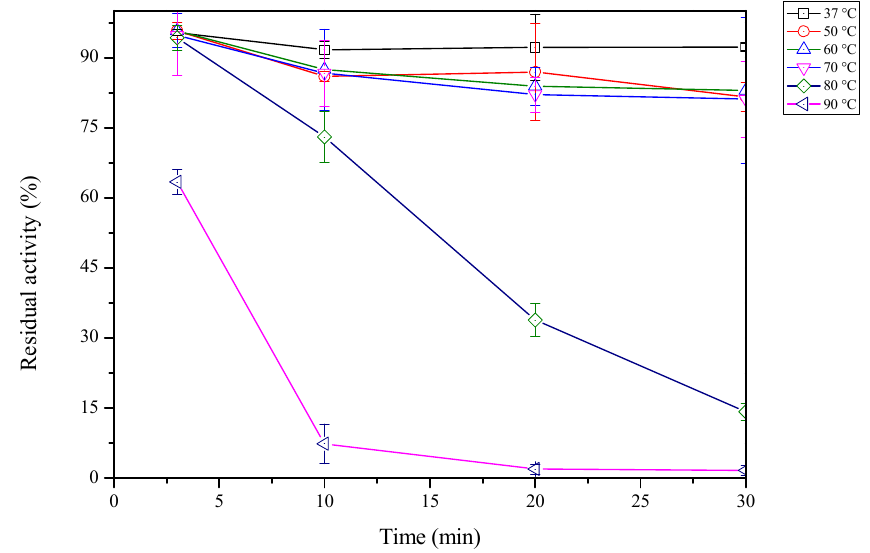
Figure 7. Thermal stability tests for sdCALA, where the initial activity was set as the control.